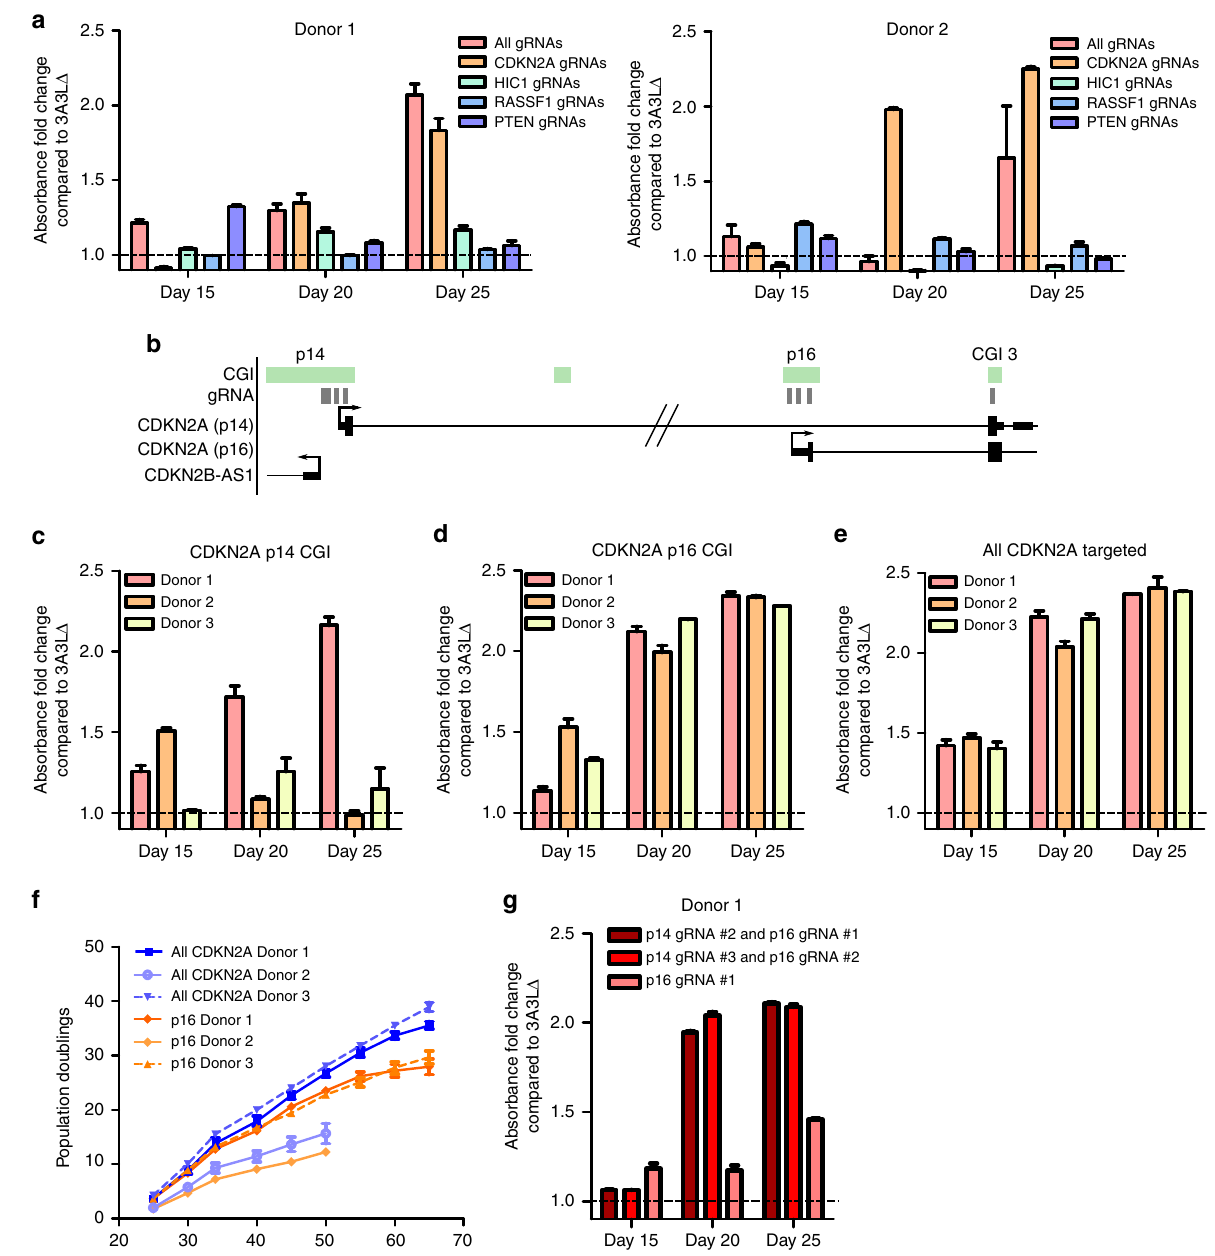
Fig. 6 Hypermethylation and repression of p16 drives the proliferative phenotype. a Proliferation was measured using a colorimetric assay 15, 20 and 25 days after targeting dCas9 3A3L or 3A3L Δ to HIC1 , RASSF1 , PTEN and CDKN2A (red), CDKN2A only (orange), HIC1 only (green), RASSF1 only (blue) or PTEN only (indigo) in donor 1 (left graph) or donor 2 (right graph) primary myoepithelial cells. Dotted lines represent the average absorbance from three dCas9 3A3L Δ targeted wells at each timepoint. The graphs show the average difference in absorbance as fold change of 3A3L compared to 3A3L Δ average (mean ± SEM, n = 3). b Schematic showing the structure of the CDKN2A locus and the location of the gRNAs (grey boxes) in relation to CGIs (green bar) and TSS of alternative transcripts p14 and p16. c - e Proliferation was assessed 15, 20 and 25 days after targeting dCas9 3A3L or 3A3L Δ to c p14, d p16 or e the whole CDKN2A locus in donors 1, 2 and 3 primary myoepithelial cells. Dotted lines represent average from three dCas9 3A3L Δ targeted wells. The fold change of 3A3L compared to 3A3L Δ average is plotted (mean ± SEM, n = 3). f Cumulative population doublings for cells from donors 1, 2 and 3 transfected with dCas9 3A3L targeting p16 with gRNAs #1, #2 and #3 (orange lines) or targeting the entire CDKN2A locus (8 gRNAs; blue lines). Fifty thousand cells were seeded at the start of each passage and cells counted after 5 days (mean ± SEM, n = 3, error bars excluded where smaller than points). g Proliferation was measured 15, 20 and 25 days after targeting dCas9 3A3L or 3A3L Δ to CDKN2A using p14 gRNA #2/p16 gRNA #1 (magenta), p14 gRNA #3/p16 gRNA #2 (red) or p16 gRNA #1 (pink) in donor 1 myoepithelial cells. Dotted line represents the average from three dCas9 3A3L Δ targeted wells. Data is plotted as fold change of 3A3L absorbance compared to 3A3L Δ average (mean ± SEM, n =